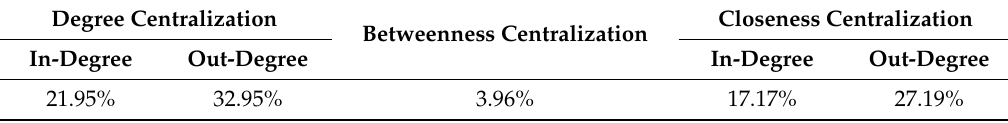
Table 5. Centralization in the e-health community.